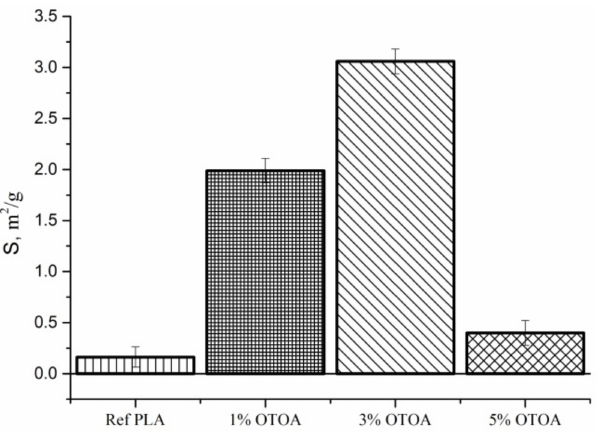
Figure 5. Specific surface area of nonwoven PLA mats: pristine PLA, PLA + 1% OTOA, PLA + 3% OTOA, PLA + 5% OTOA